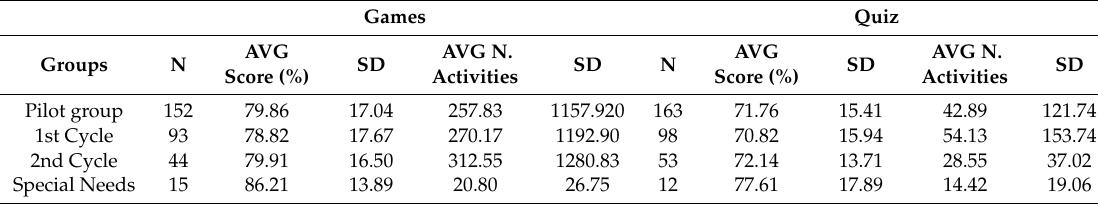
Table A2. Descriptive statistic scores at all games and quizzes played by Pilot Group 1.